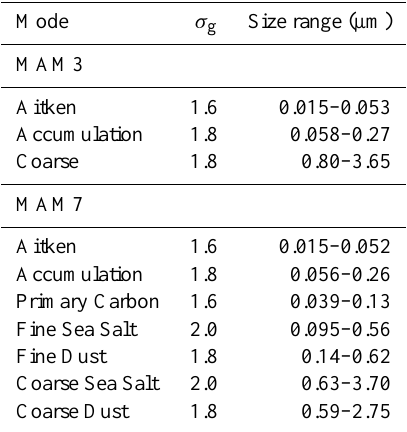
Table 1. Geometric standard deviations ( σ g ) and dry diameter size ranges for MAM3 and MAM7 modes. The size range values are the 10th and 90th percentiles of the global annual average number distribution for the modes (from simulations presented in Sect. 3).